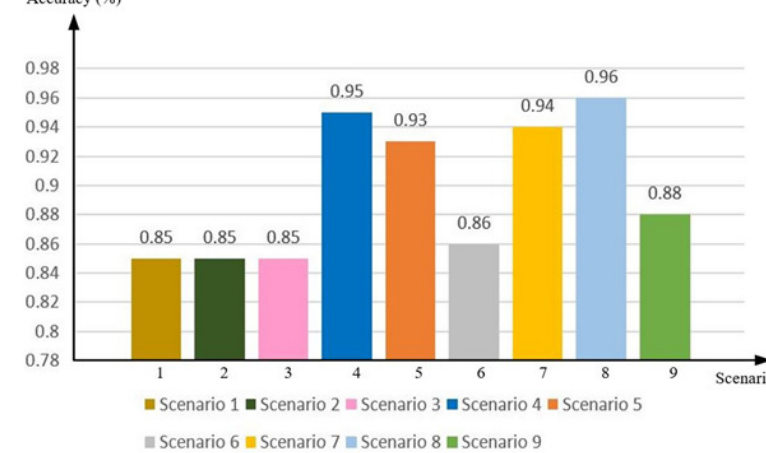
Figure 22. Average accuracy for Scenarios 1 to